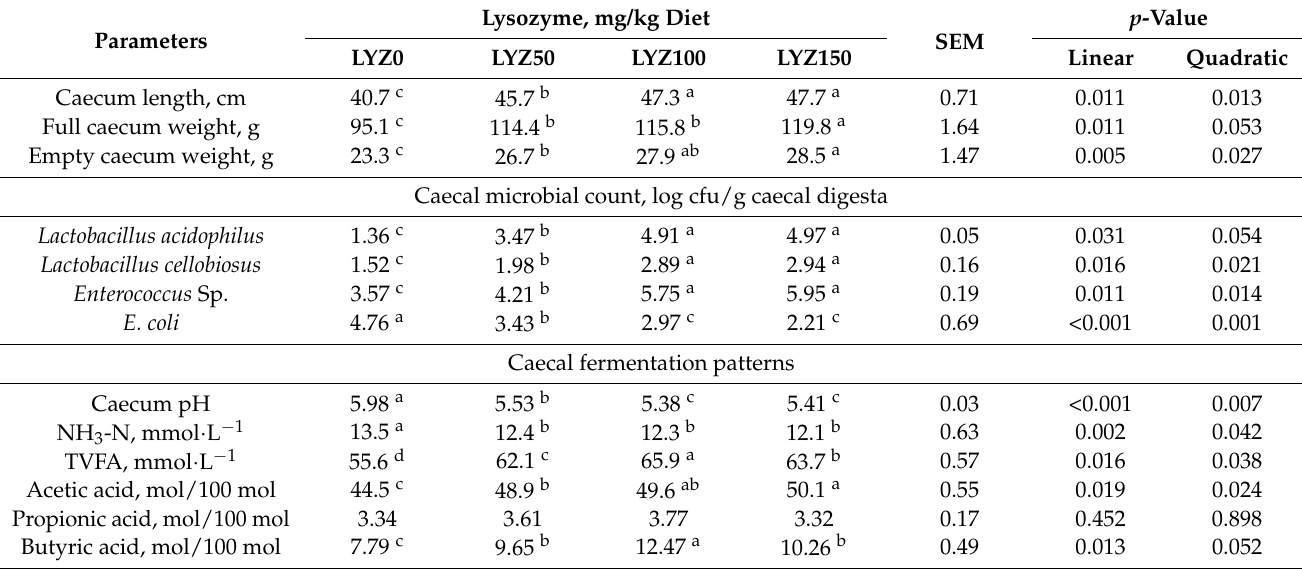
Table 5. Caecal microbiota and fermentation of growing rabbits fed diets supplemented with different levels of lysozyme at 72 days of